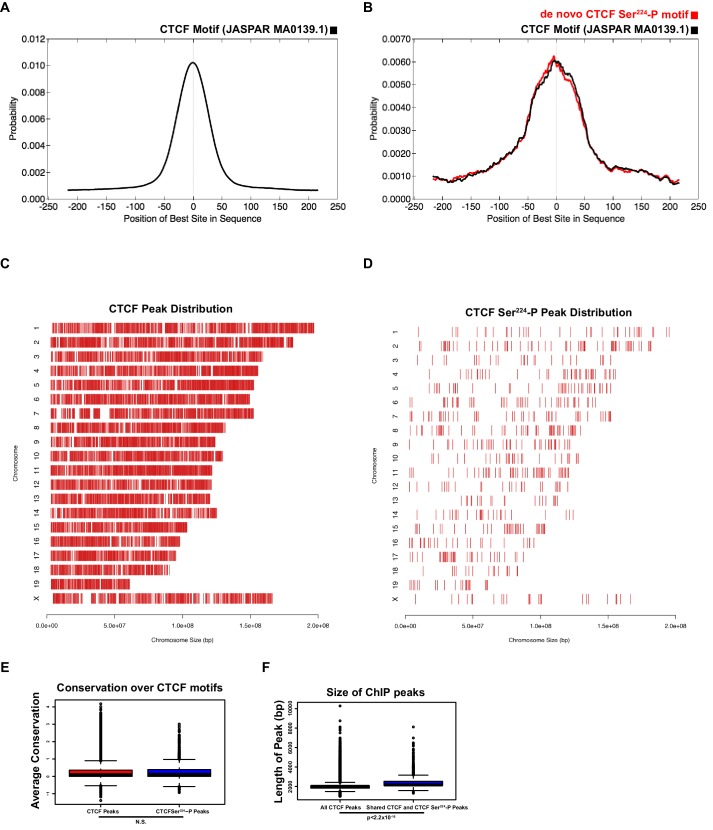
CTCF Ser224-P occupies known CTCF binding sites.(A) CentriMo site probability distribution plot generated from CTCF ChIP-seq called peaks (z = 6) with the observed consensus CTCF motif plotted (black trace). (B) Site probability distribution plot generated from CTCF Ser224-P ChIP-seq called peaks (z = 6) with both de novo identified (red) and consensus CTCF (black) motifs plotted. (C–D) CTCF and CTCF Ser224-P ChIP-seq peak (z = 6) distribution plots across all chromosomes. (E) Average conservation of CTCF motifs falling in CTCF versus CTCF Ser224-P ChIP-seq peaks (p-value>0.05, Wilcoxon rank sum test). (F) Length of CTCF peaks versus shared CTCF and CTCF Ser224-P peaks (p-value<2.2×10−16, Wilcoxon rank sum test).